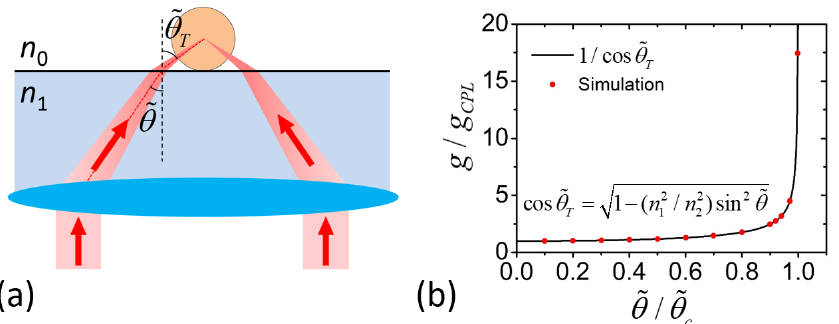
Figure 3. ( a ) The model to analyze light scattering by the sphere in the superchiral field. The incident field is the vectorial Bessel beam with orbital angular momentum of Equations (32) and (33), with the topological charge, m 0 = ± 1. The refractive indexes of the substrate and air are n 1 = 1.518 and n 0 = 1. The incident angle is (cid:101) θ , and the refraction angle is (cid:101) θ T ( b ) The enhancement factor of the chiral signal from a dipole at the focus ( r = 0). g and g CPL are the CD factors under the superchiral light and circularly polarized light (CPL) light. 𝜃̃ 𝑐 represents the critical angle of total reflection.